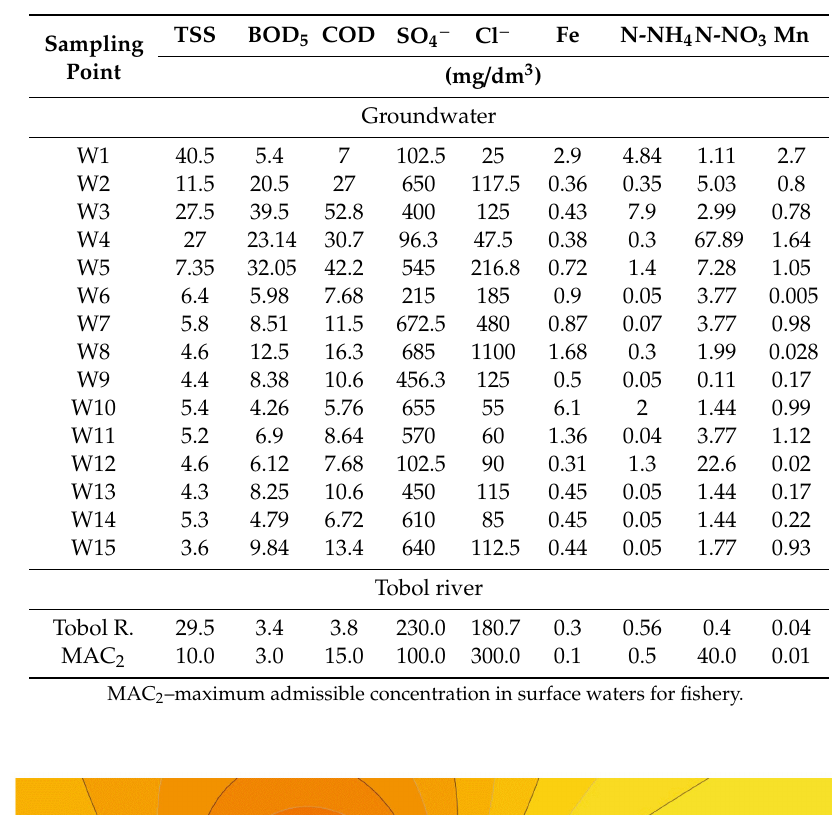
Table 4. Average values of the selected quality parameters of groundwater and the Tobol River.